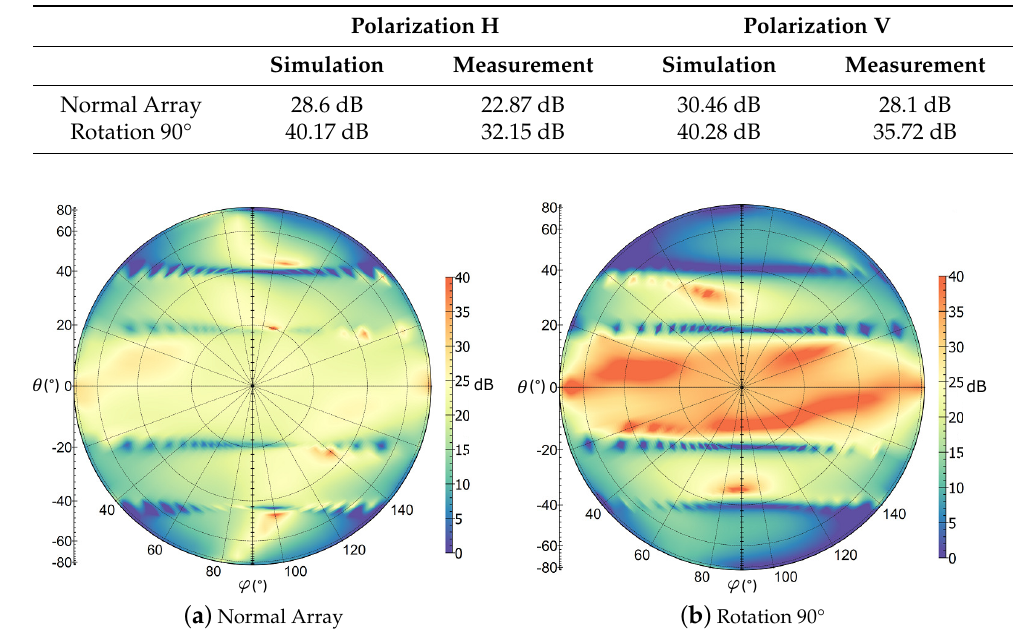
Table 6. Comparison of the cross-polarization suppression @ f 0 = 1.325 GHz. Uniform amplitude and phase distribution.